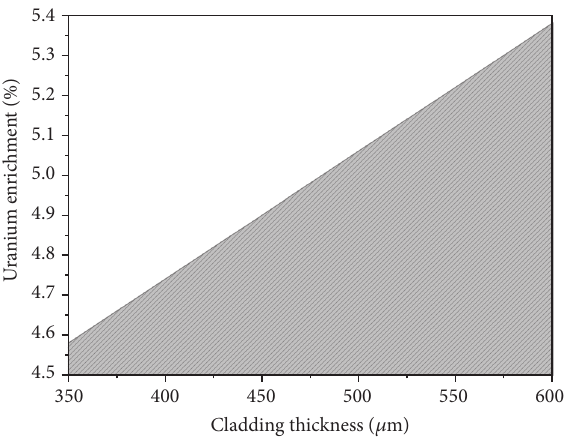
Figure 6: Feasible combination in consideration of cycle length.